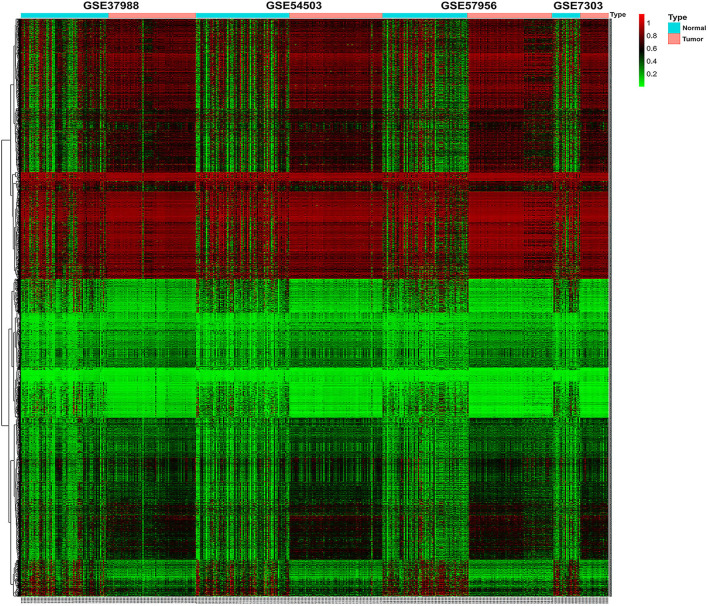
Heatmap of β values of the top 1,000 differentially methylated CpG sites in HCC patients and their corresponding adjacent normal samples in four GEO datasets. Rows represent differentially methylated CpG sites, and columns represent samples; light blue and pink represent normal and tumor tissues, respectively; green and red represent the low and high β values, respectively.